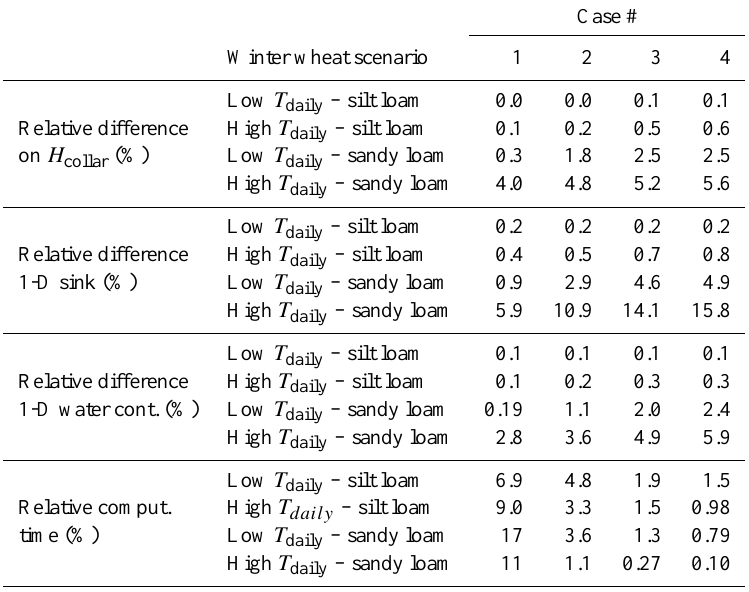
Table 3. Relative absolute differences on ψ collar , 1-D sink terms, 1-D water contents and computing times in the winter wheat scenarios, for increasing soil element sizes. Refer to Table 1 for the detailed geometry of cases